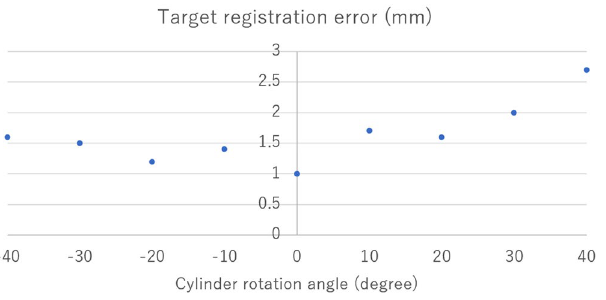
Figure 7. The target registration error. The target registration error was 1.63 ± 0.49 mm (range, 1–2.7 mm) with respect to the rotation angle of the lens cylinder from 40° to −